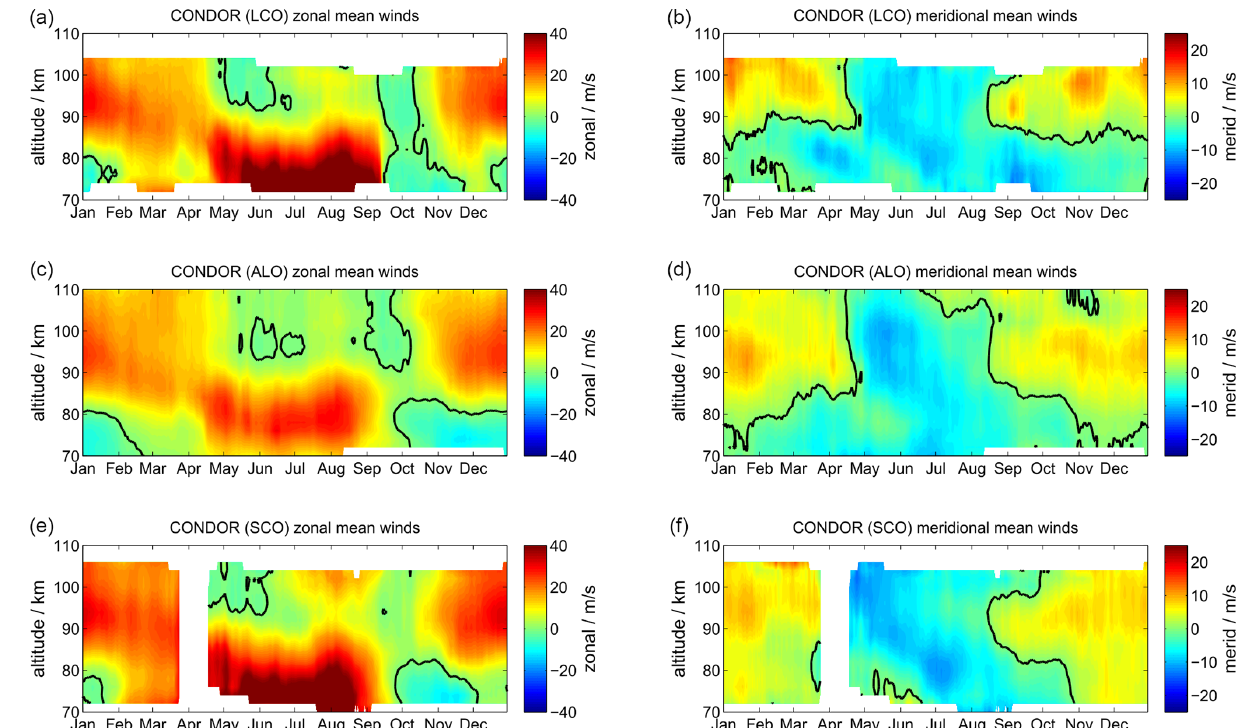
Figure 3. Comparison of zonal and meridional winds as a composite from 2012 to 2021 for the forward scatter receiver stations LCO and SCO as well as the monostatic radar in ALO. The left column ( a , c , and e ) shows the zonal wind component, and the panels on the right ( b , d , and f ) show the meridional wind. The panels are sorted according to their geographic latitude, with the northernmost sampling volume at LCO on top, the ALO in the center, and the southernmost station SCO in the lowest